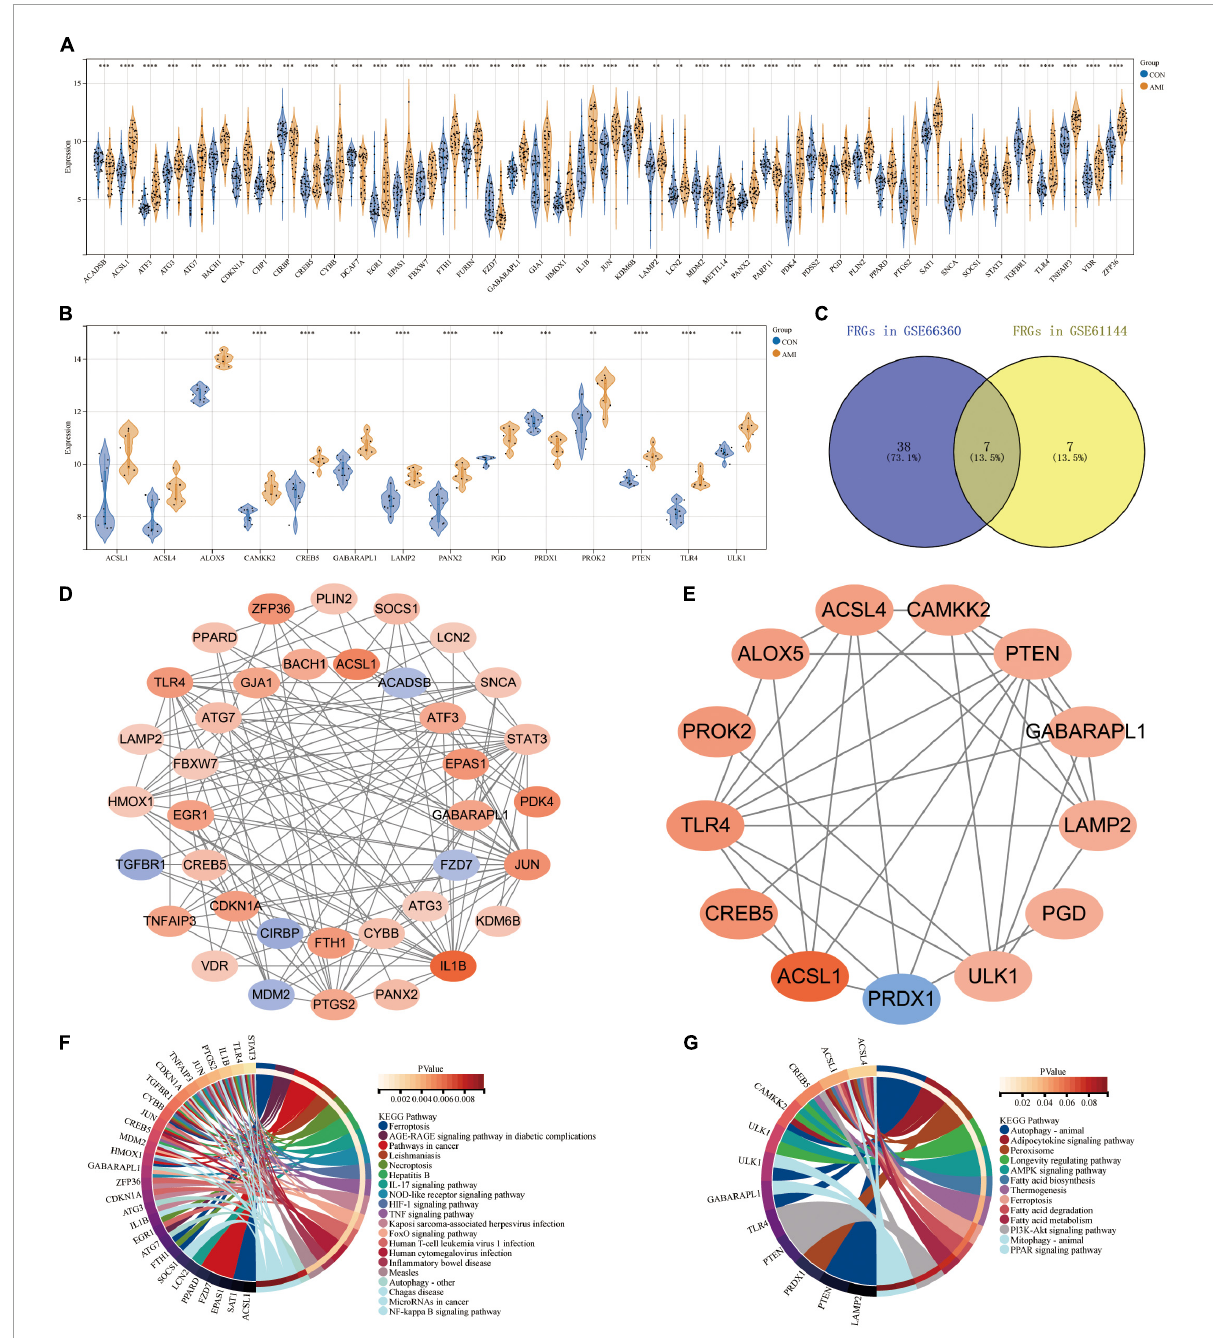
FIGURE4 Expression patterns of FRGs in GSE66360 and GSE61144. (A) Expression patterns of FRGs in GSE66360. (B) Expression patterns of FRGs in GSE61144. (C) Venn diagram of FRGs in GSE66360 and GSE61144. (D) PPI network of FRGs in GSE66360. (E) PPI network of FRGs in GSE61144. (F) Circle plot of KEGG pathway enrichment analysis for FRGs on GSE66360. (G) Circle plot of KEGG pathway enrichment analysis for FRGs on GSE61144. (A,B) ** P < 0.01; *** P < 0.001; **** P < 0.0001.